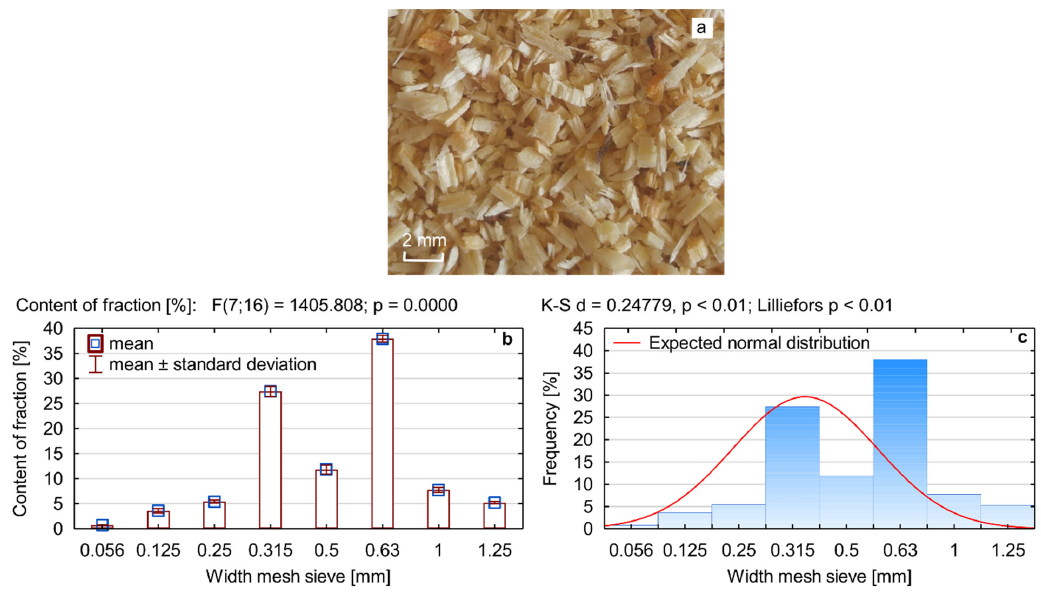
Figure 1. Sawdust used as a filler for PUR foam: ( a ) image, ( b ) fractional composition, ( c ) normal distribution.